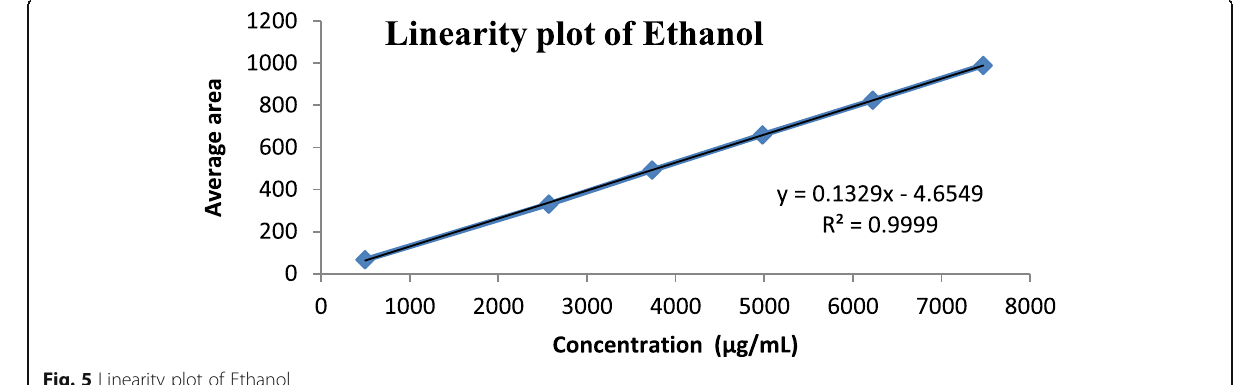
Fig. 5 Linearity plot of Ethanol